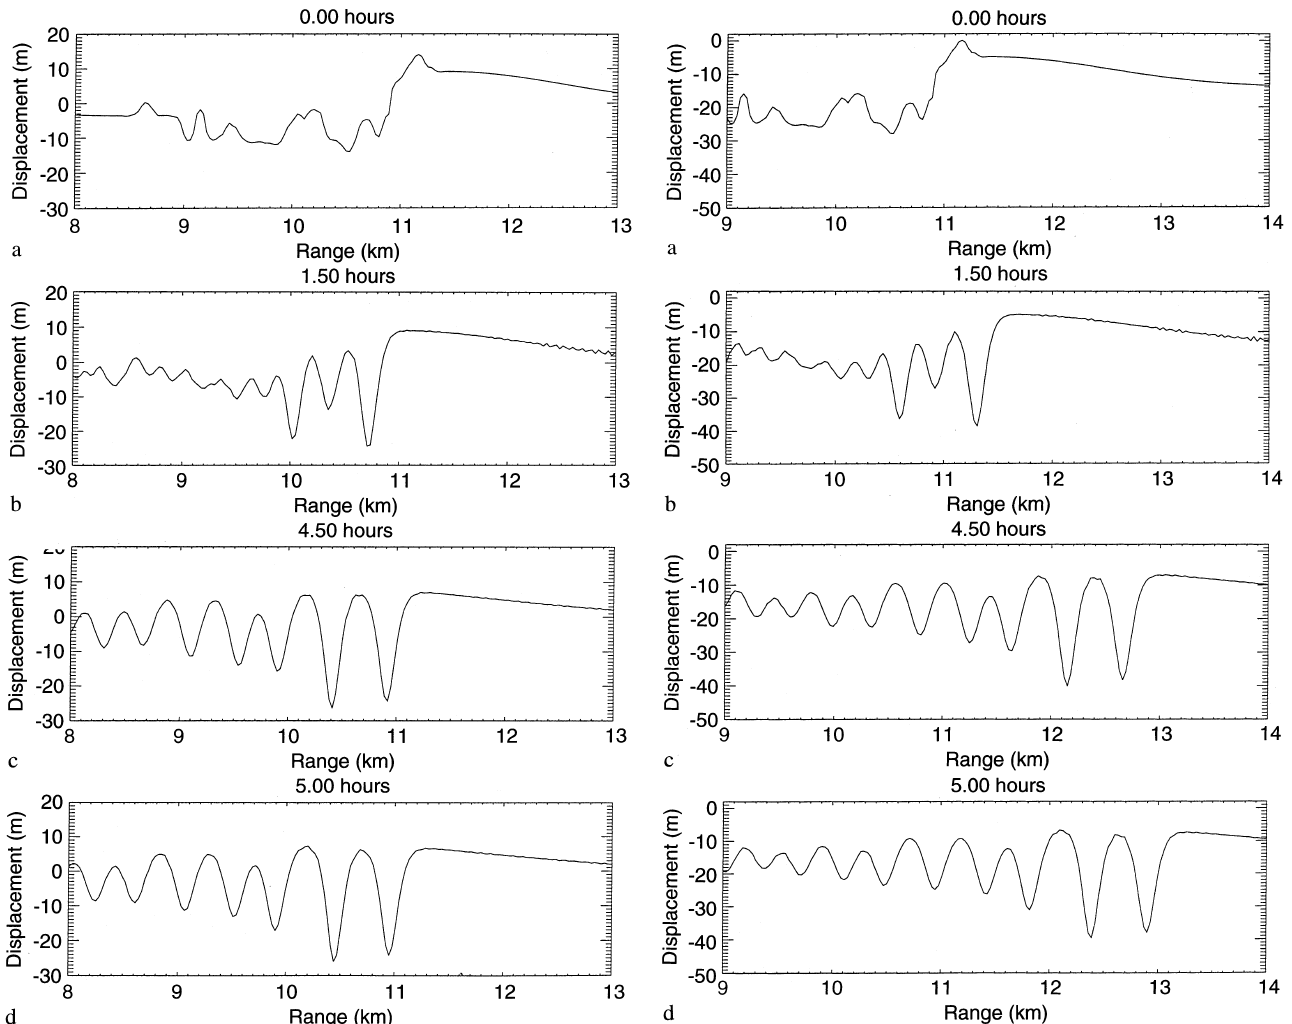
Fig. 15a–d. KdV model results for experiment 2, showing the displacement g . a Initial waveform, from the first survey; b model run after 1.5 h; c after 4.5 h, and d after 5 h. Range axis is ( x ) c t ) 0 with an